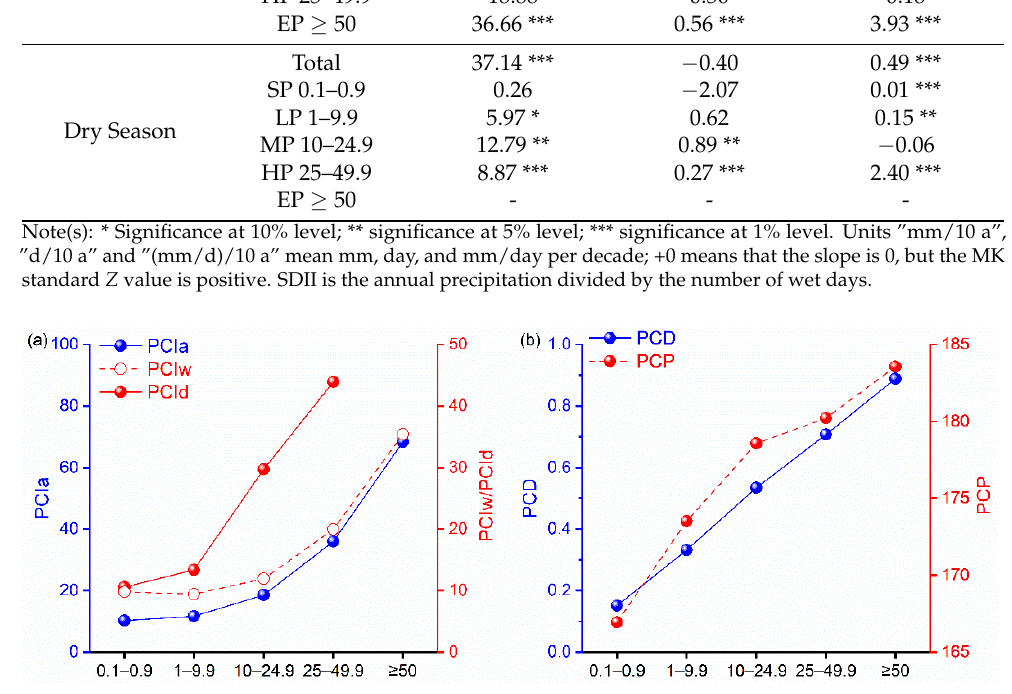
Table 3. The correlation coefficients between the amount of precipitation and the PCI, the amount of precipitation and the PCD, the amount of precipitation and the PCP, and the PCI and PCD for the annual amount of precipitation and each intensity level for the Daning River basin.